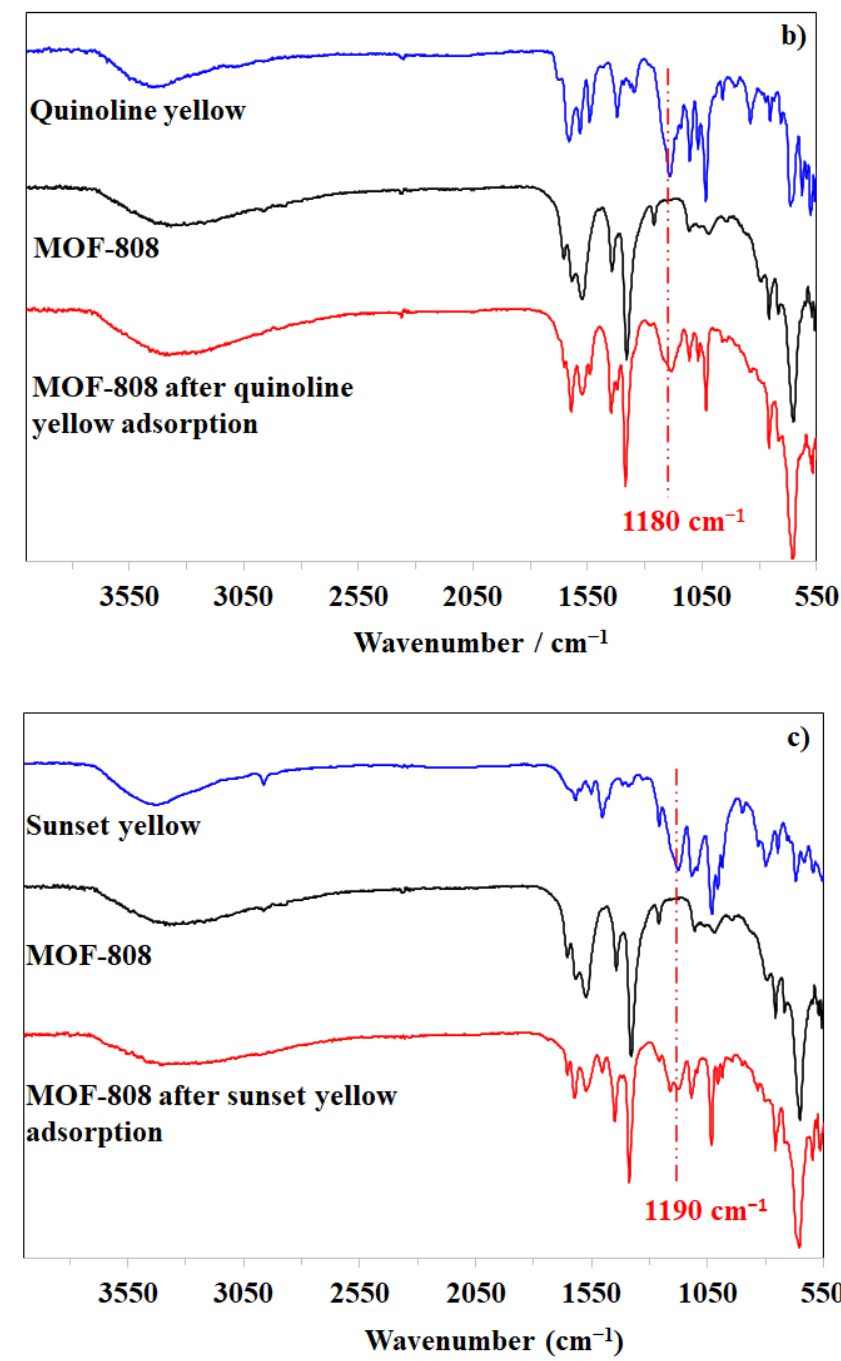
Figure 13. FT-IR spectra of MOF-808 samples after capturing K 2 Cr 2 O 7 ( a ), quinoline yellow ( b ), and sunset yellow ( c ) .